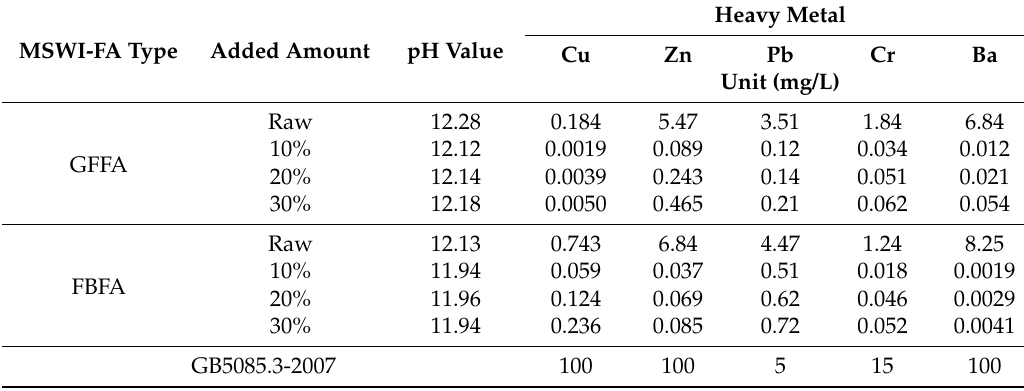
Table 5. The results of the leaching test using the analytical method HJ/T 299-2007.